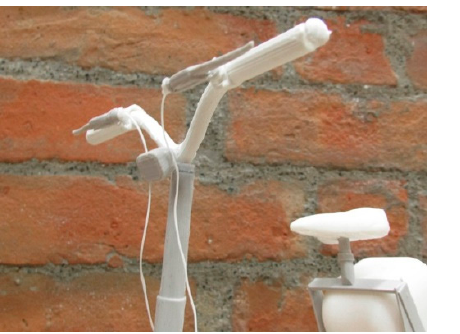
Figure 23. 3D printing bike.